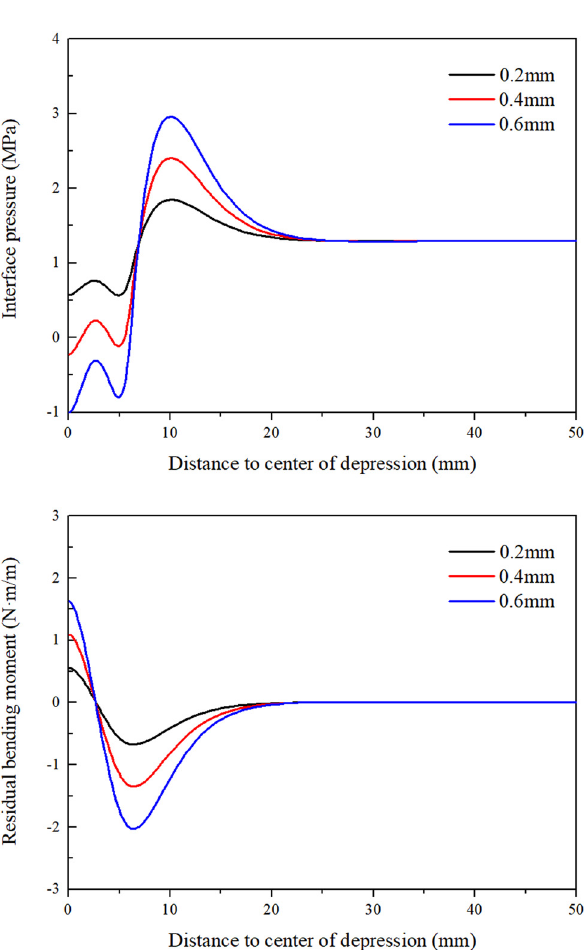
Figure 6: Distribution of ( a ) interface pressure and ( b ) residual bending moment near depressions after autofrettage.